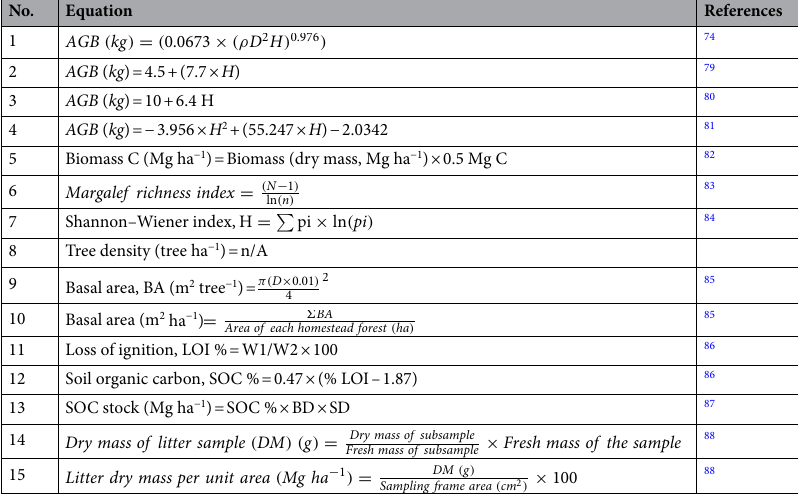
Table 2. Equations used in analyses of data. AGB (kg) is above-ground biomass, ρ wood density (g cm −3 ), D is tree DBH (cm), H tree height (m), N the total number of species, n the total number of individuals of all species, pi is the ratio of S to n, where, S denotes individuals of each species in a homestead forest, A an area of the homestead forest (ha), W 1 is the loss in mass (g), W 2 mass of oven-dried soil (g), BD bulk density of soil (g cm −3 ), SD soil depth